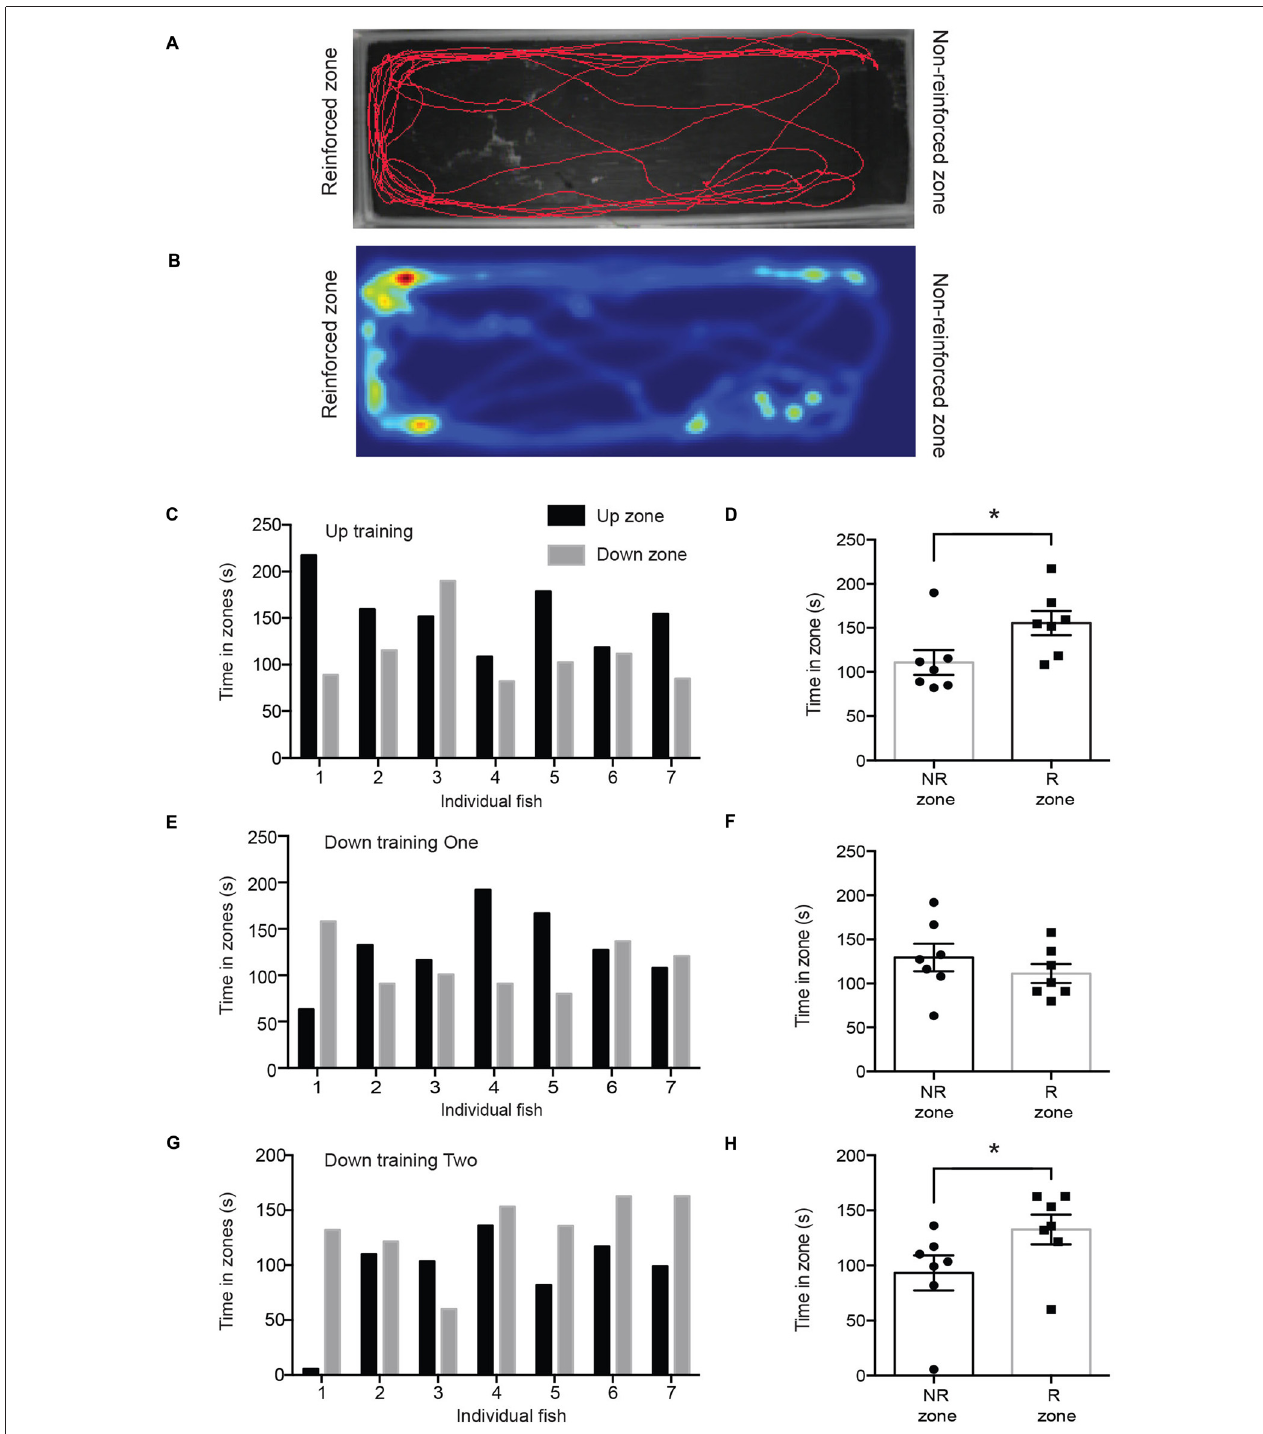
FIGURE 2 | (A) Trackplot of representative fish during one trial of testing period 1. (B) The heatmap is a colored representation of the same fish and is proportional to the time spent in each pixel. (C) During training session 1, the up zone was reinforced and in test period 1 all fish except for one spent more time in the up zone. (D) Fish spent significantly more time in the reinforced zone (R zone) than in the non-reinforced zone (NR zone; reinforced zone; 155.5 ± 13.8 s; non-reinforced zone; 110.7 ± 14.1 s; ∗ p = 0.0423). (E) During training session 2 the down zone was reinforced. This graph shows the time spent in the up or down zone during test period 2. (F) Fish did not spend significantly more time in the reinforced zone (R zone) compared to that in the non-reinforced zone (NR zone; reinforced zone; 129.5 ± 15.7 s; non-reinforced zone; 111.2 ± 10.7 s; p = 0.1774) in test period 2. (G) During test period 3, after the down zone had been reinforced a second